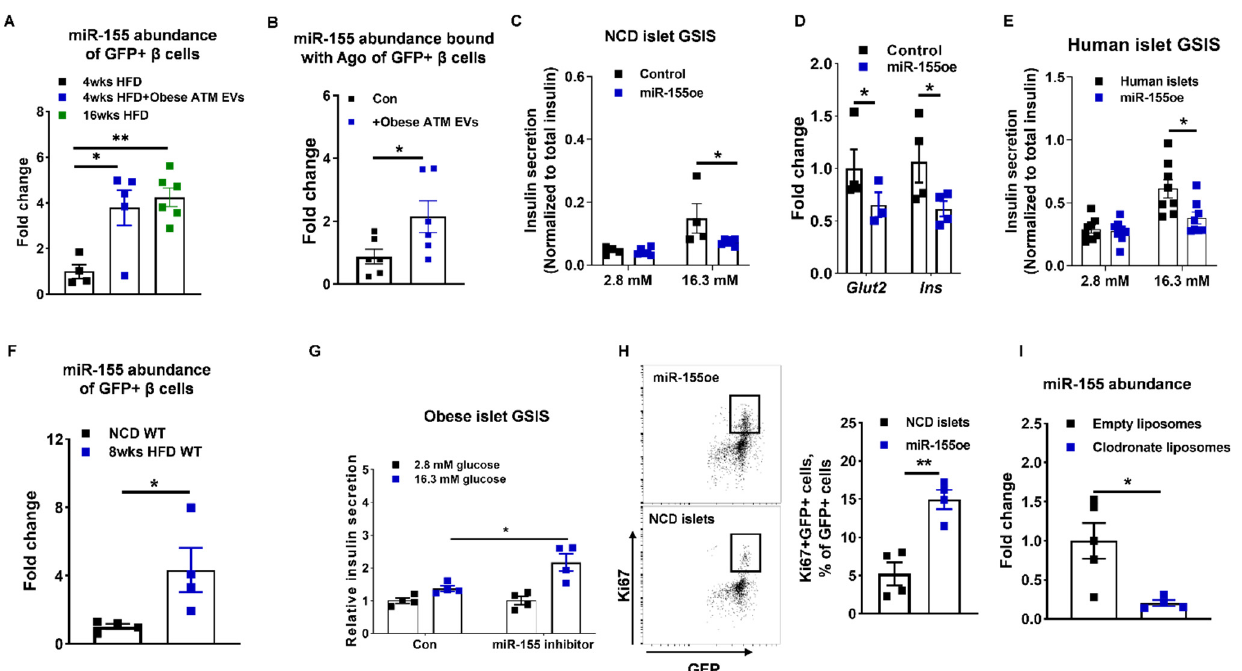
Figure 5. miR-155 accumulation leads to a reduction in insulin secretion but an increase in β Cell proliferation. ( A ) miR-155 abundance of GFP+ cells after 4 weeks HFD MIPGFP-Mki67 mice treated with obese ATM EVs for 4 weeks. ( B and C ) The effect of miR-155 overexpression (miR-155oe) on the GSIS and genes associated with insulin secretion of NCD islets. ( E ) Effect of miR-155 overexpression on human islet GSIS. ( F ) miR-155 abundance of GFP+ cells isolated from NCD or 8 weeks HFD MIPGFP-Mki67 mice. ( G ) The GSIS of obese islets after transfection of miR-155 inhibitor. ( H ) The proportion of Ki67+GFP+ cells in NCD MIPGFP-Mki67 islets transfected with miR-155 mimics. ( I ) miR-155 abundance in islets of obese mice treated with either empty liposomes or clodronate liposomes. Data are presented as the mean ± SEM. N = 4 ( A , C and D , F – H ), N = 5–6 ( B and I ), N = 8 ( E ) per group. * p < 0.05, ** p < 0.01, Student’s t test ( B , D , F , H and I ), one-way ( A ) or two-way ( C , E , and G ) ANOVA.